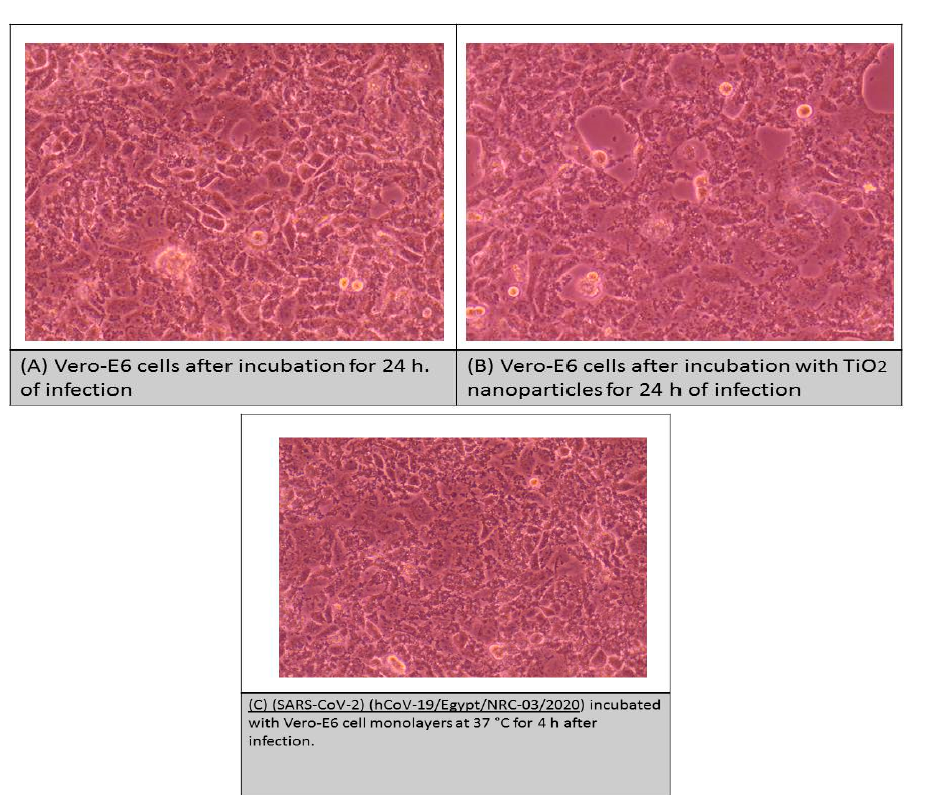
Figure 9. ( A – C ) Images for Vero-E6 host cells (After infection) after the incubation with SARS- CoV-2 and treated with TiO 2 -NPs which showed potent anti-viral activity of TiO 2 -NPs against SARS–Cov-2, the sheet of cells treated with TiO 2 -NPs showing high enlarged patches around SRAS-CoV-2 cells, thus demonstrating the ability of TiO 2 -NPs (nanostructures) to disinfect SARS-CoV-2 and offer a high level of inhibition to its growth. Respiratory Syndrome Coronavirus 2 (SARS-CoV-2) (hCoV-19/Egypt/NRC-03/2020). Differences between zinc oxide nanoparticles (ZnO-NPs) inhibition activity [23–27]